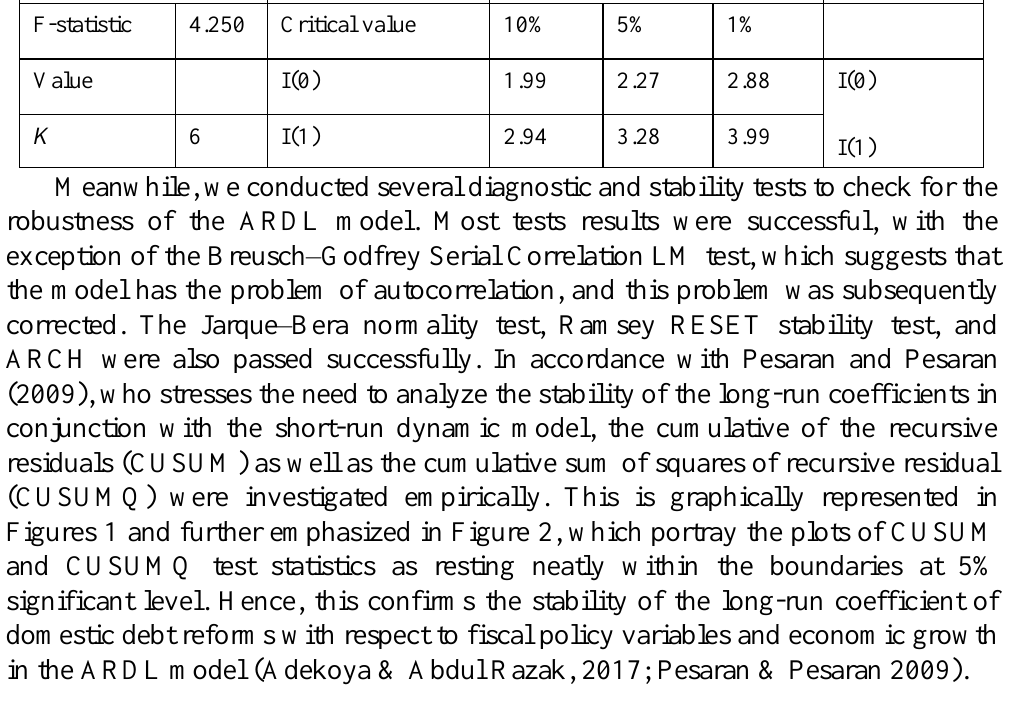
Table 5. Result of the diagnostic test for ARDL